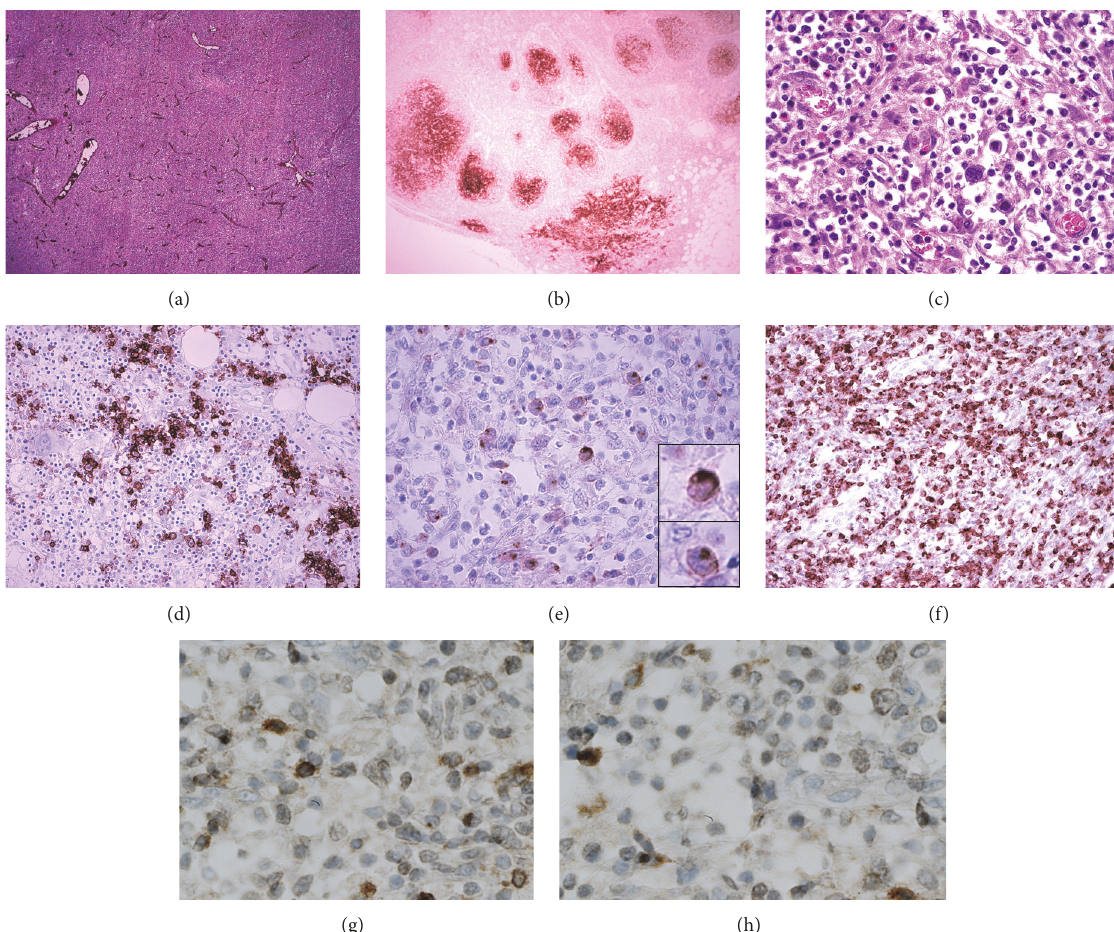
Figure 1: The histology and immunohistochemistry of a lymph node. (a) Gross examination of the lymph node architecture shows prominent vessels, suggesting the formation of the arborizing high endothelial venules. (b) The expanded CD21-positive follicular dendritic cell meshworks. (c) Hematoxylin and eosin stain showing polymorphous background infiltrate composed of medium sized atypical lymphocytes and enlarged pleomorphic cells with unilobated nuclei and prominent nucleoli, resembling RS-like B-cells. (d) The RS-like B-cells have less prominent CD20 expression in comparison to the B-lymphocytes present in the polymorphous infiltrate. (e) The RS-like B-cells are CD30- positive with characteristic paranuclear dot-like staining. (f) The lymphoid population consists of the CD2-positive atypical T-lymphocytes that often form rosettes around RS-like B-cells. (g) and (h) Atypical T-lymphocytes are CD10- and BCL6-positive.